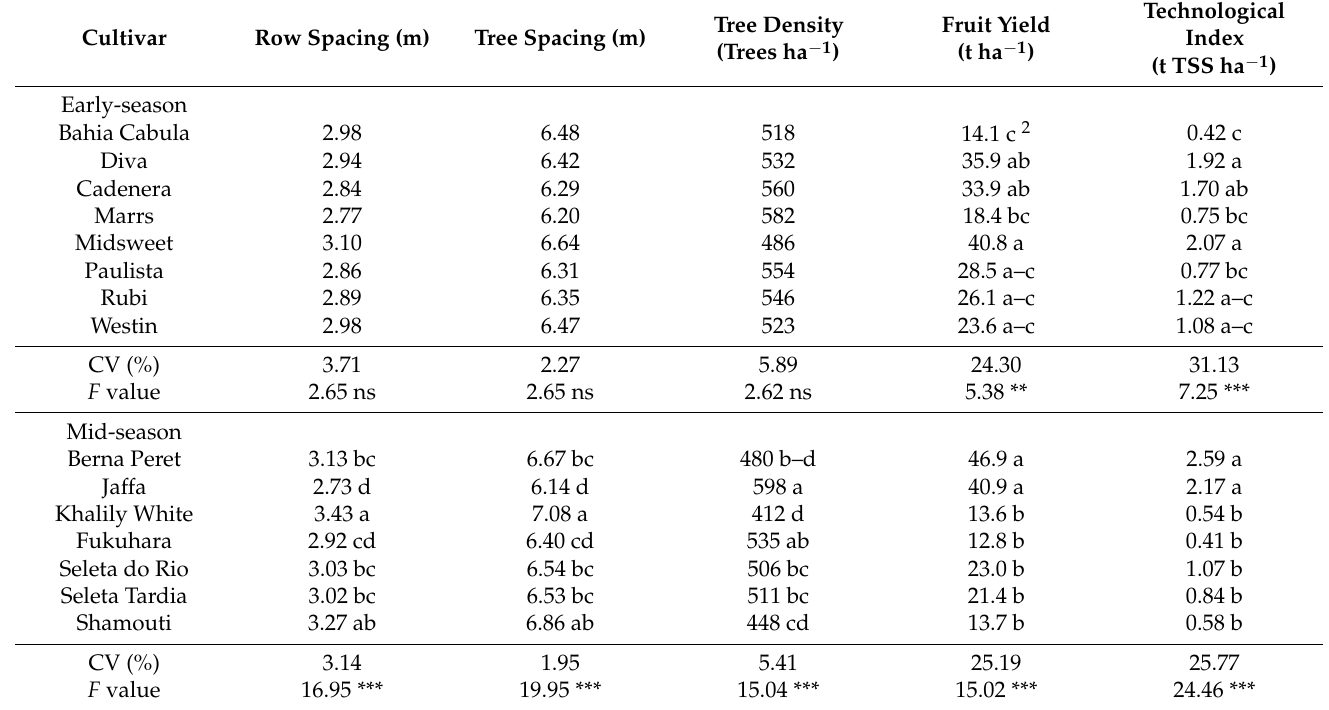
Table 6. Estimates 1 of minimum row and tree spacing and maximum tree density, yield, and techno- logical index for 15 early-season and mid-season sweet orange cultivars based on field performance in Guairaç á , Paran á , Brazil, from 2012 to